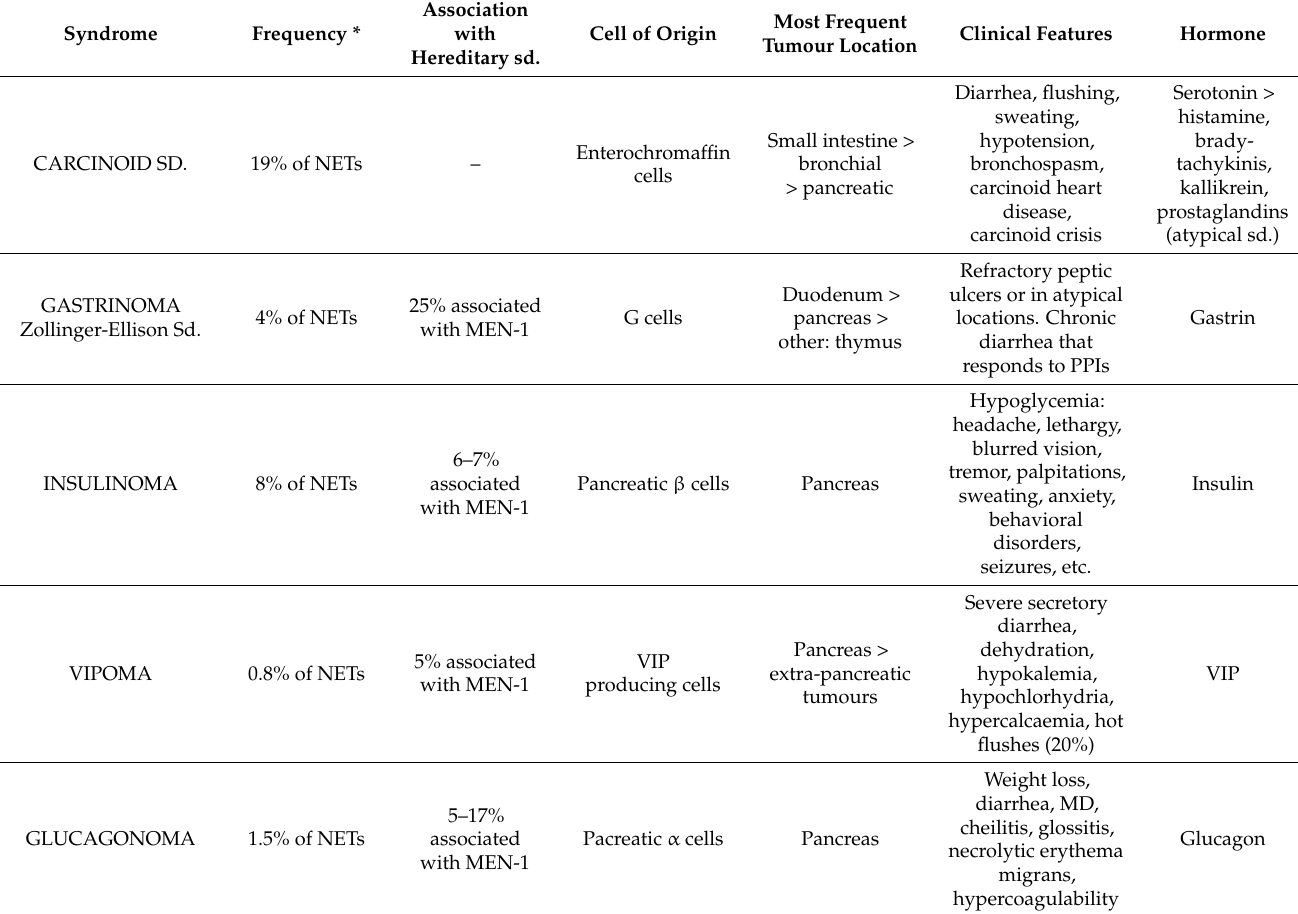
Table 1. Main syndromes and clinical manifestations of